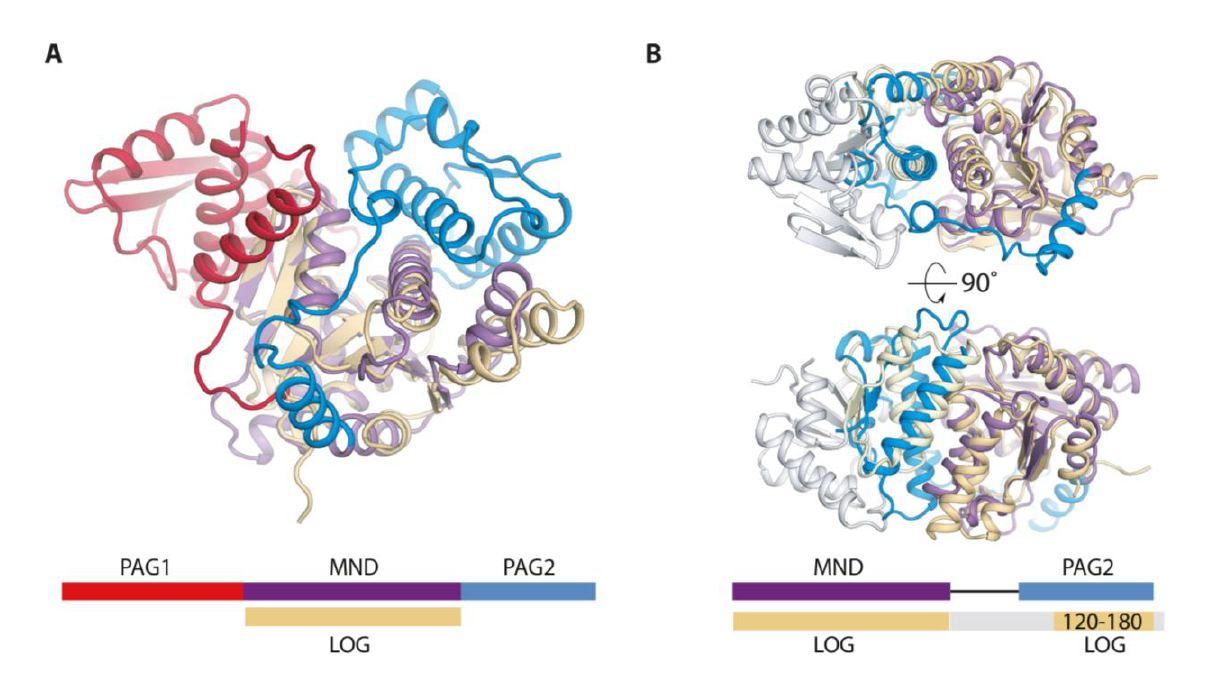
FIGURE 2: Structual comparison of E. coli PpnN and a LOG protein ( A. thaliana lysine decarboxylase-like protein, PDB ID 2A33). (A) Com- parison between a monomer of PpnN (purple, red, and blue) and LOG (beige) shows that the Rossmann-like fold is shared between the two families. Schematic in same colors below the structure for emphasis. (B) Superposition of a LOG dimer (grey and beige) onto the MND and PAG2 domain of PpnN reveals conserved secondary elements between LOG and PAG2 (yellow), more precisely two α -helices and two ter- minal β -strands. Schematic in same colour below show where the LOG dimer share secondary structure (beige) and the rest is coloured in